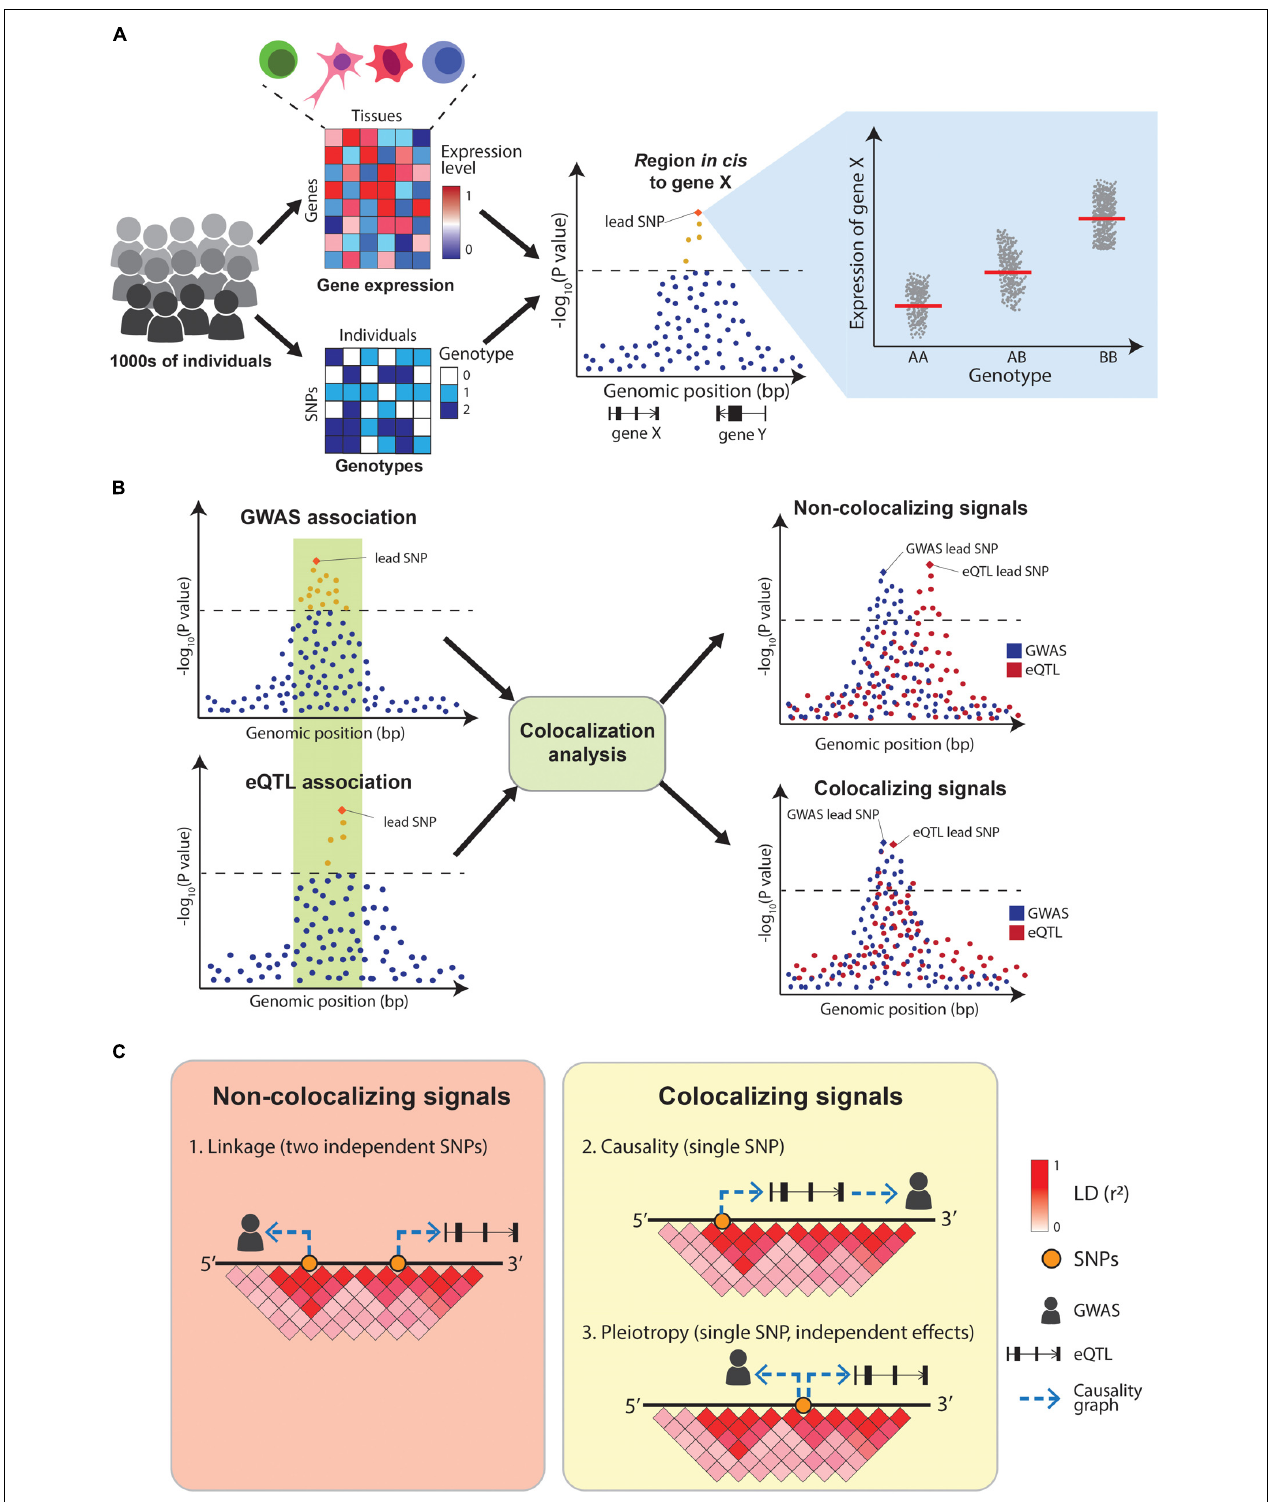
FIGURE 3 | Overview of eQTL-mapping and colocalization. (A) In eQTL-mapping gene expression is profiled in thousands of individuals and the expression level of each gene is tested for association with genotypes at nearby ( cis ) SNPs. (B) Colocalization compares the association patterns of GWAS and eQTLs at a locus to find if both signals are driven by the same causal variants. (C) GWAS and eQTL signals can overlap for three reasons: two independent causal variants in LD (linkage), a single causal variant affecting the GWAS trait via gene expression modulation (causality) or a single causal variant affecting both traits independently (pleiotropy). A positive colocalization supports causality or pleiotropy in favor of